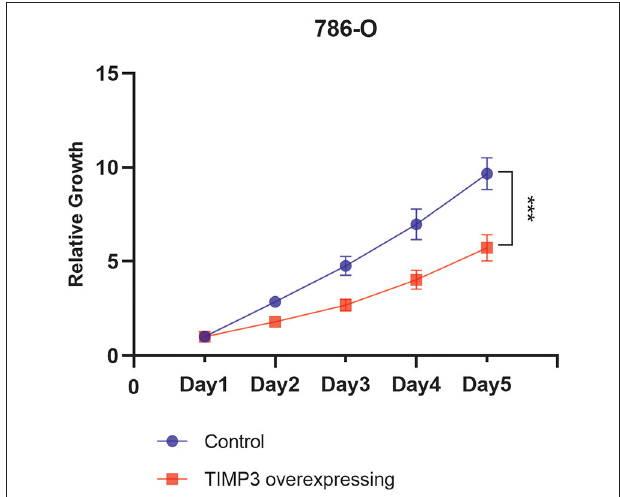
FIGURE 9 | The proliferation curve of 786-O cells, which showed that the proliferation of tissue inhibitor of metalloproteinase 3 (TIMP3)-overexpressing 786-O renal cancer cells was significantly inhibited (*** p <